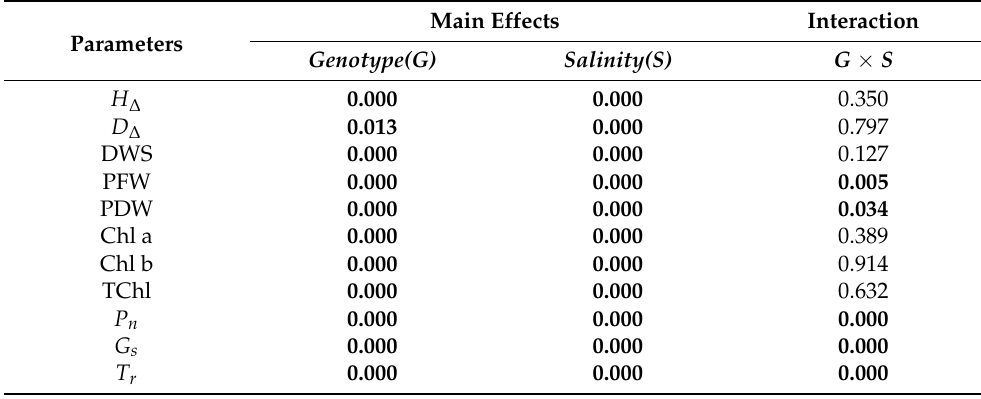
Table 2. Main and interactive effects of genotype and salinity on growth, and physiological and biochemical parameters of